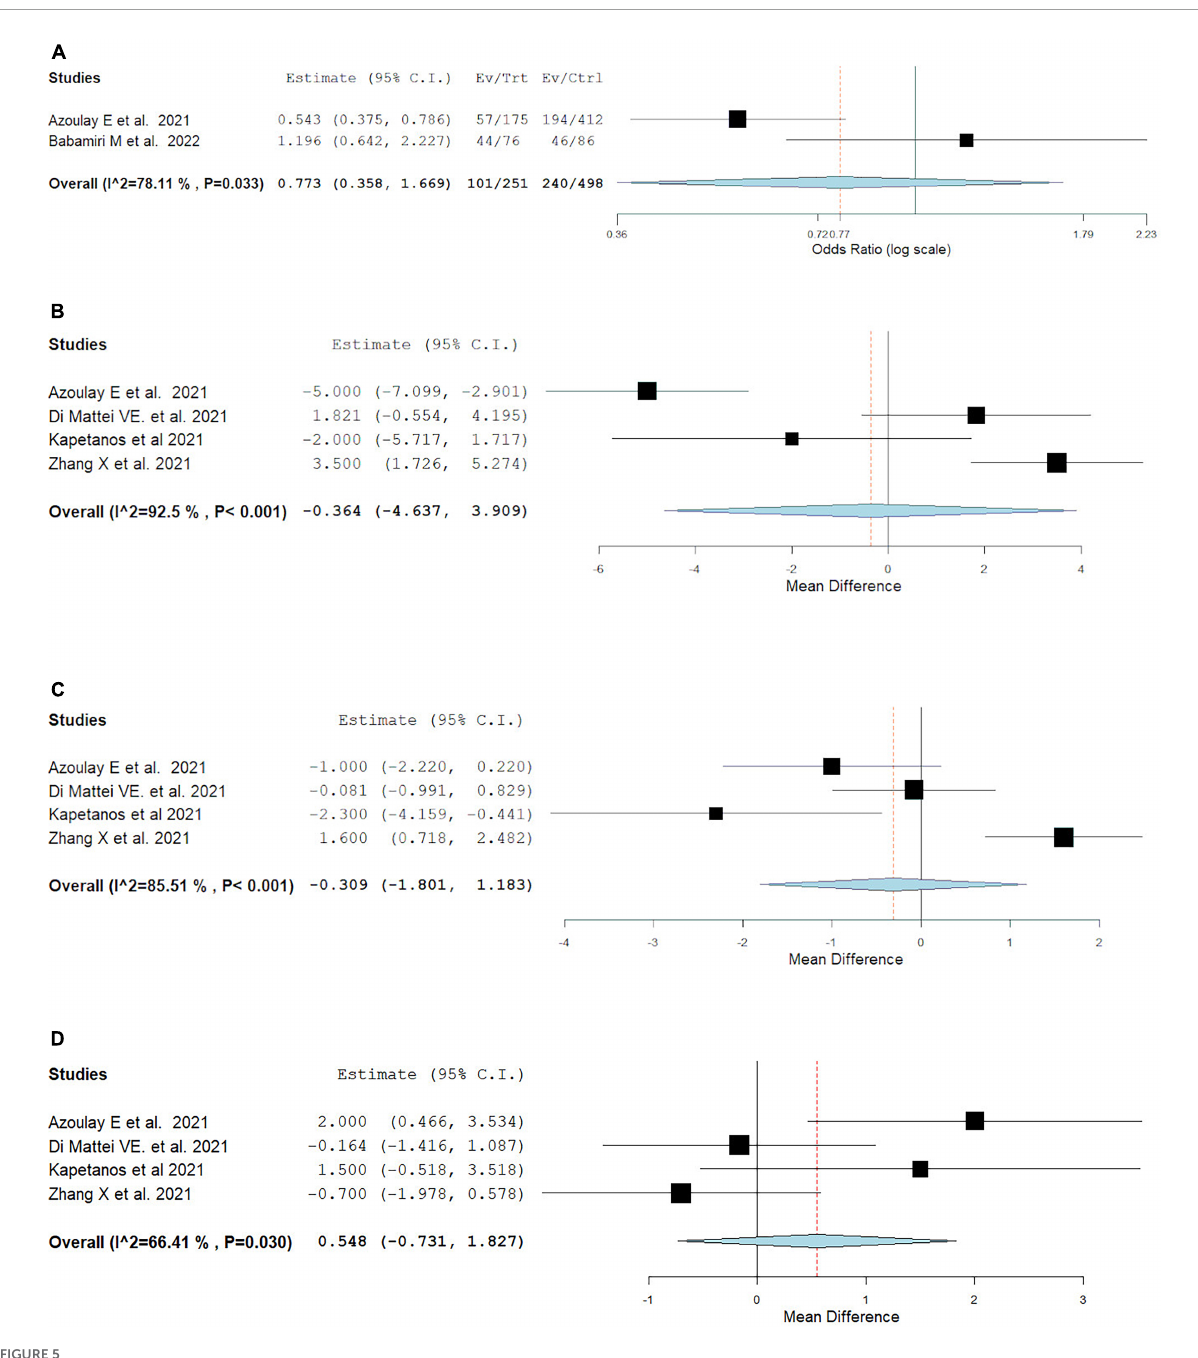
FIGURE5 Pooled estimate of burnout prevalence in nurses vs physician according to Maslach burnout inventory by (A) overall prevalence, (B) emotional exhaustion prevalence, (C) depersonalization prevalence, (D) personal accomplishment